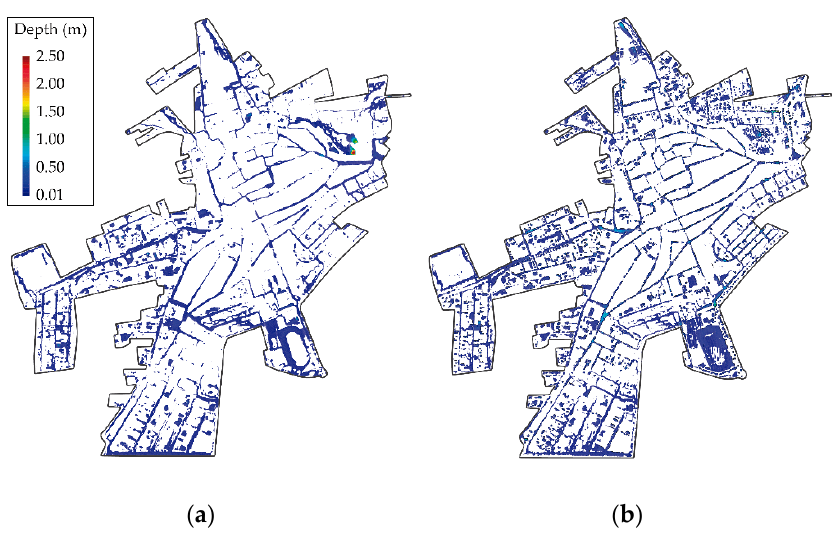
Figure 13. Maximum depths on the surface: ( a ) with and ( b ) without considering the sewer network.